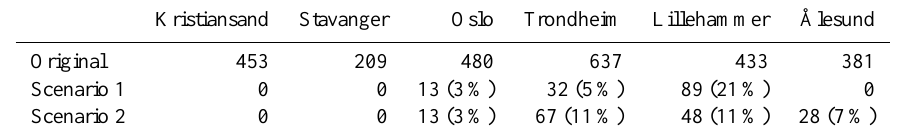
Table 2. Distances between Bergen and other cities with intact road network and excess distances following road closures specified in scenarios 1 and 2, given in km. Ratio of excess distance to original route length shown in parentheses.